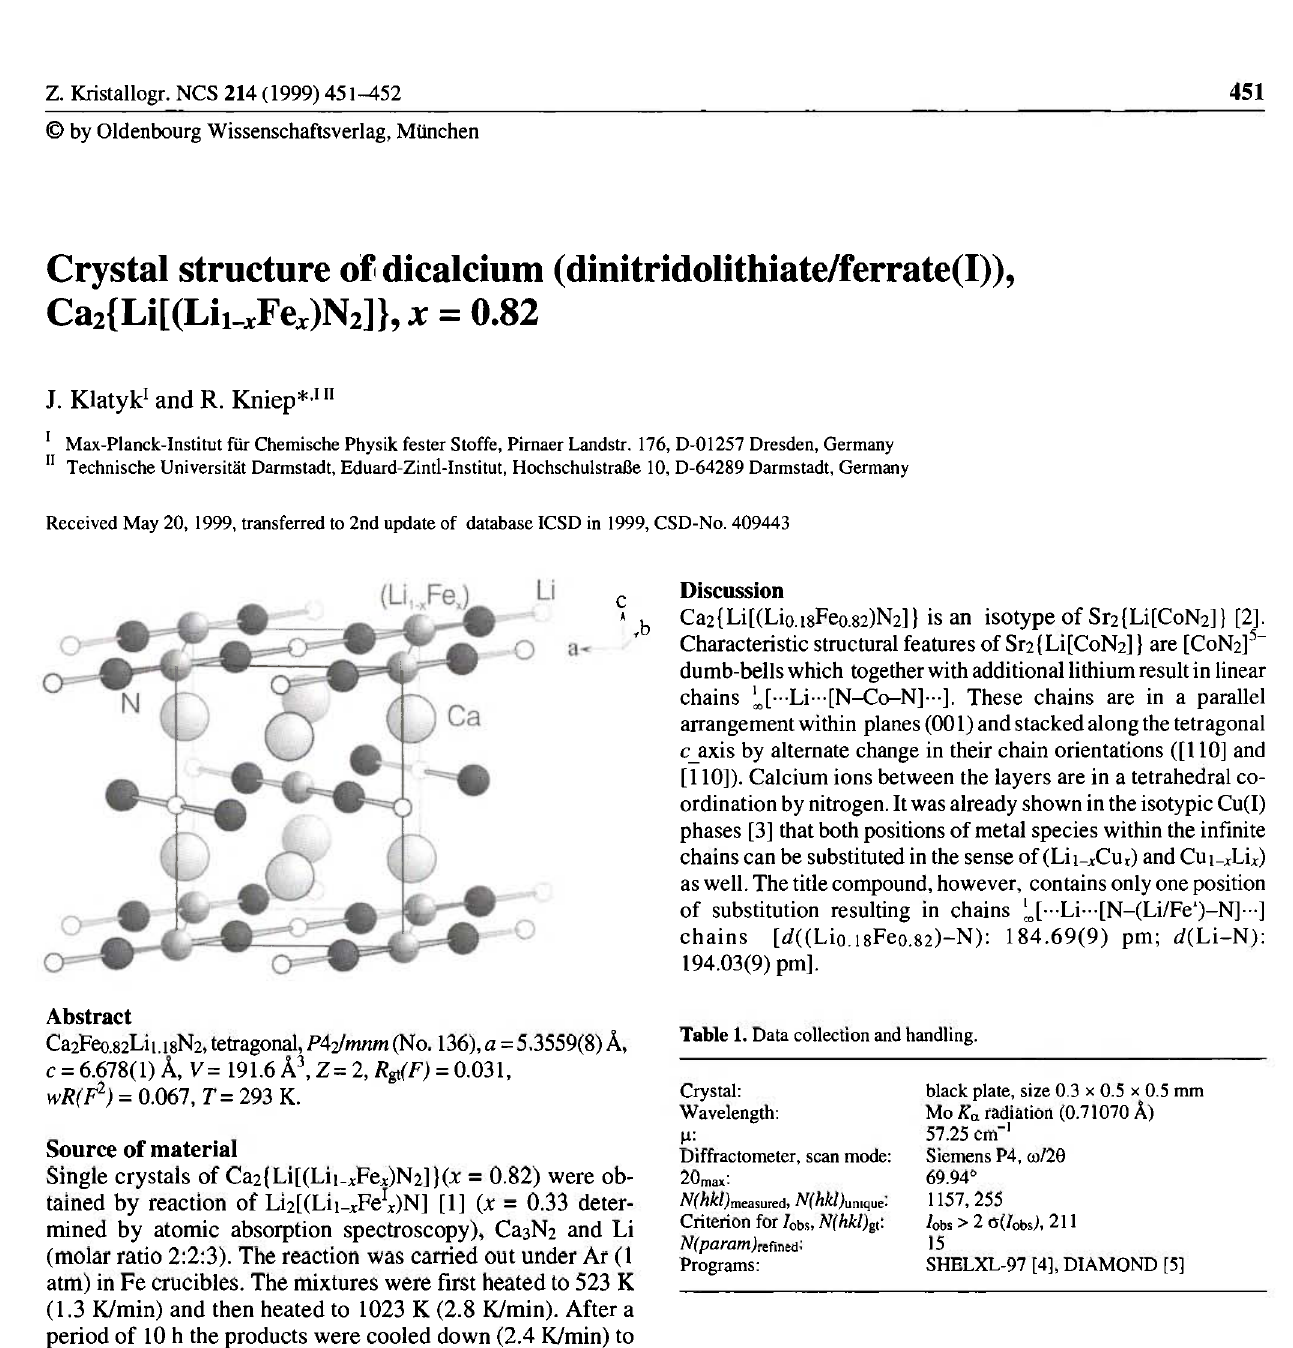
Table 2. Atomic coordinates and displacement parameters (in Ä 2 ).